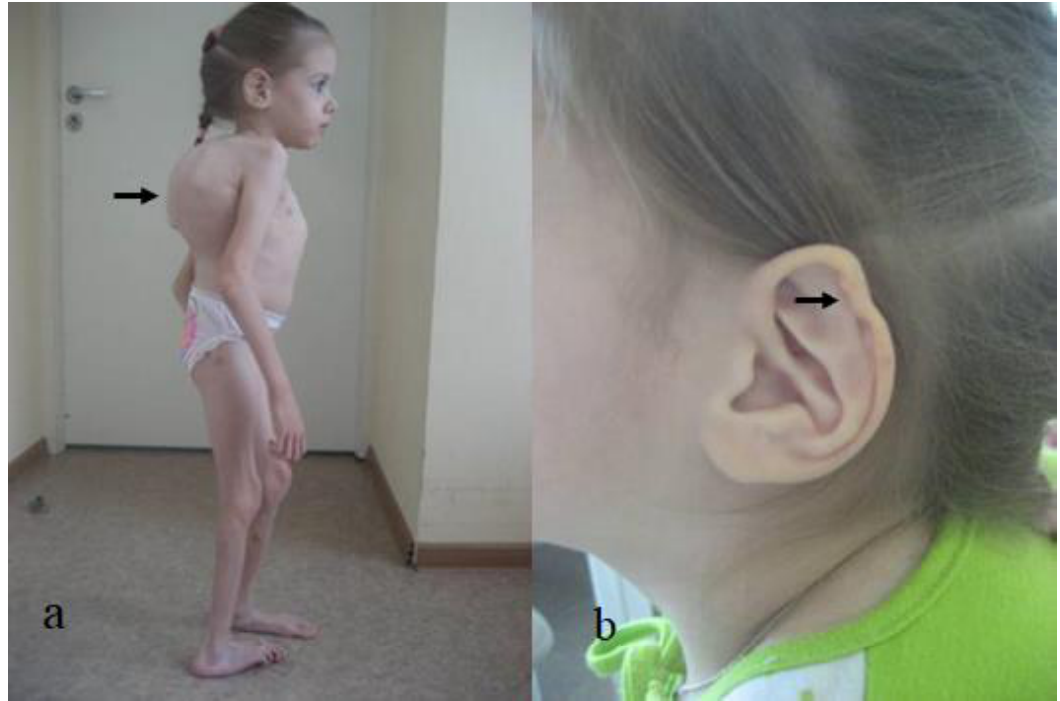
Figure 6. Clinical phenotype of a 4-year-old girl showed marfanoid habitus, a long face with a large and wide frontal area, hypertelorism, marfanoid-like features (thin and long slender limbs), kyphoscoliosis (arrow), long fingers (arachnodactyly) and apparent bilateral pes equinovalgus. The head was brachycephalic, with a long philtrum and a high vault palatine ( a ); The ears showed specific abnormalities (helix was flattened and crumpled, with some loss of the architecture (arrow)) ( b ).